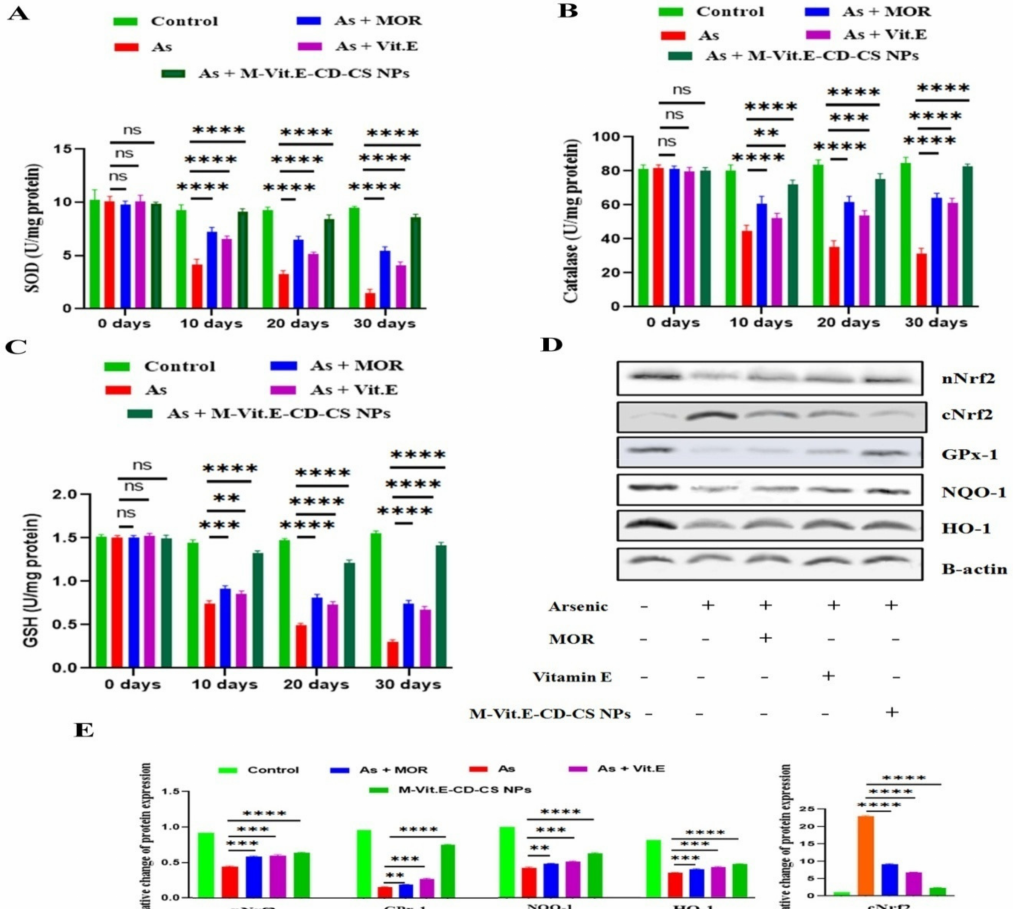
Figure 5. Effect of MOR, vitamin E, and M-Vit.E-CD-CS NPs on antioxidant factors.